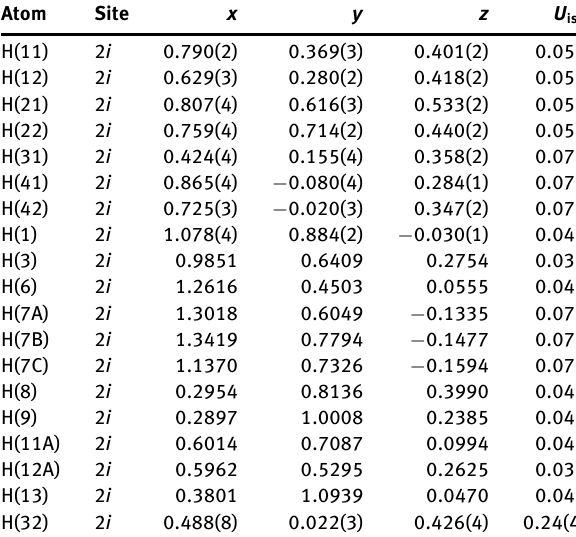
Table 2: Fractional atomic coordinates and isotropic or equivalent isotropic displacement parameters (Å 2